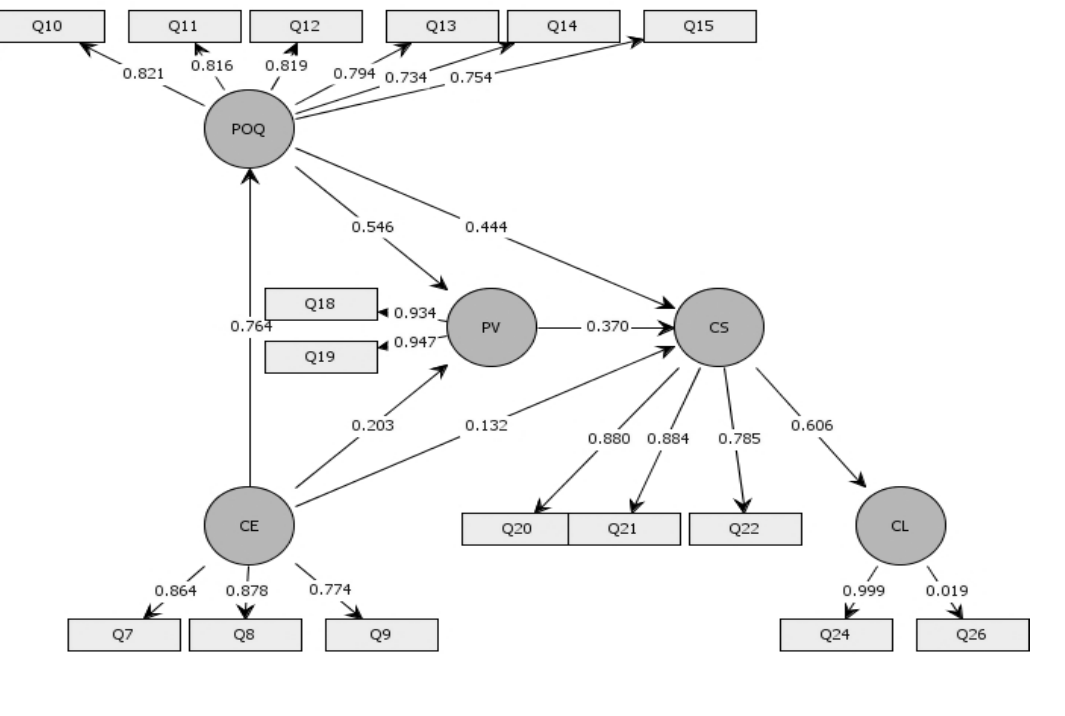
Figure 2: Expanded ACSI model for the motor vehicle industry Table 2: Variance explained and composite reliability of the motor vehicle industry